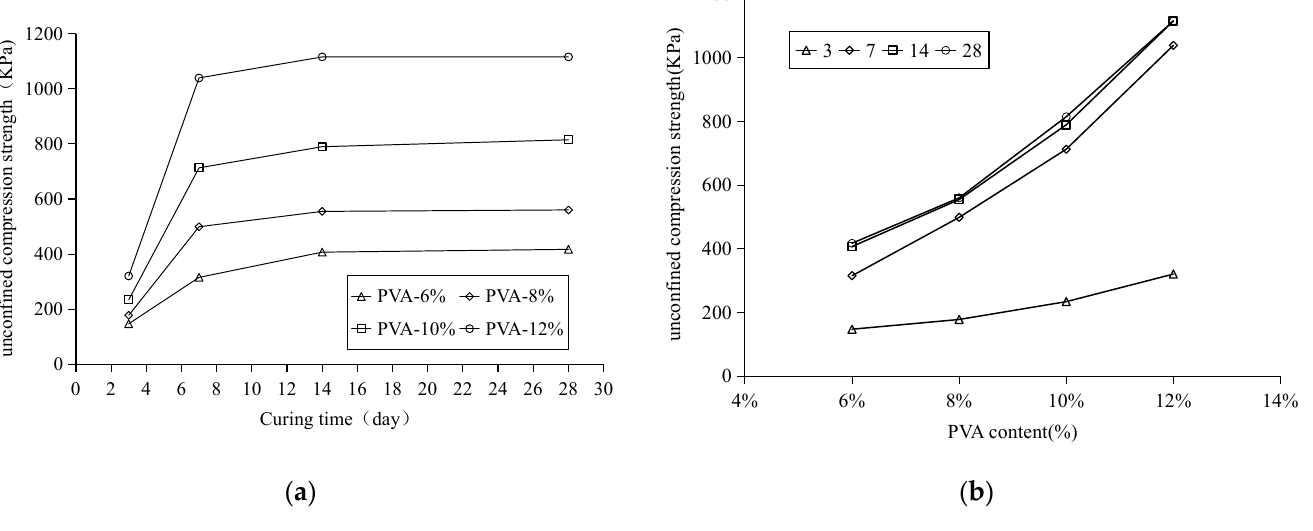
Figure 4. ( a ) UCS change curve with different curing time; ( b ) UCS change curve with different PVA content; Relationship between UCS and curing age of polyvinyl alcohol modified samples.